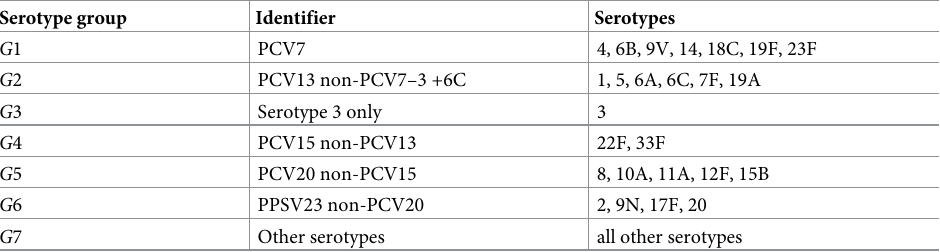
Table 1. Overview of the seven serotype groups defined in the model.